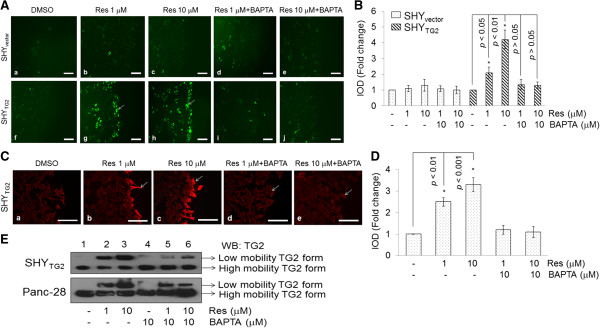
Changes in intracellular Ca2+ levels in response to resveratrol. (A) Representative fluorescence images showing the level of intracellular Ca2+ in SHYvector and SHYTG2 cells. After 48 h resveratrol treatment in scratch assays, cells were labeled with Ca2+-indicator dye, Fluo4-AM, for 1 h, and examined under fluorescence microscope using FITC filter. Cells treated with resveratrol were also treated with cell permeable Ca2+ chelator, BAPTA-AM (10 μM) to chelate intracellular Ca2+ in cells. Scale bar = 100 μm. Fluorescence intensity in cells present near the scratch was measured using Image-Pro Plus software and plotted as fold change in IOD (B). (C) Representative immunofluorescence images for TG2 in scratch assays. SHYTG2 cells were grown in chamber slides and scratch assays were performed in presence of Ca2+ chelator, BAPTA-AM (10 μM), alone or in combination with resveratrol (1 or 10 μM). After 48 h treatments, cells were labeled with anti-TG2 antibody (red) and images were taken randomly from the edge of the scratch using fluorescence microscope equipped with rhodamine filter. Enhanced red intensity in cells present near the scratch (white arrows) depicts increased immunoreactivity for TG2 that was attenuated in presence of Ca2+-chelator, BAPTA-AM. Scale bar = 100 μm. Fluorescence intensity in cells present near the scratch was measured using Image-Pro Plus software and plotted as fold change in IOD (D). (E) Representative Western blots for TG2 in presence of a Ca2+-chelator, BAPTA-AM, showing that resveratrol-induced slower mobility TG2 form is sensitive to Ca2+ levels. Native proteins isolated from resveratrol treated SHYTG2 and Panc-28 cells in the presence or absence of BAPTA-AM (10 μM) from near the scratch were isolated, separated under non-denaturing conditions, and blotted with anti-TG2 antibody. The experiments were repeated three times.